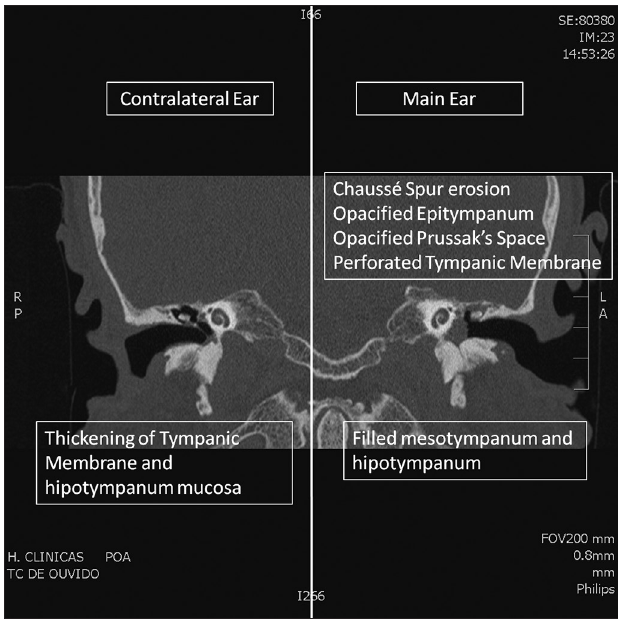
Figure 2. Coronal CT Scan. Comparison of abnormalities in the main (left) and contralateral (right)